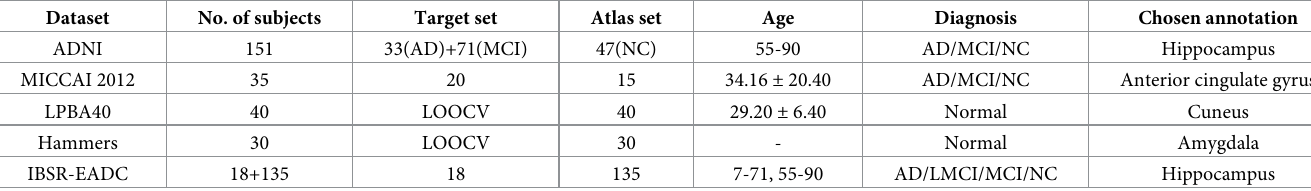
Shown dataset characteristics include the number of subjects in the dataset, the number of volumes in our split target set and atlas set, age, diagnosis, and the chosen structure segmentation for experiments. Since IBSR-EADC contains two datasets, the age information is separated by a comma. LOOCV: leave-one-out cross- validation. AD: Alzheimer’s disease subjects. MCI: mild cognitive impairment subjects. NC: normal control healthy subjects. LMCI: late mild cognitive impairment